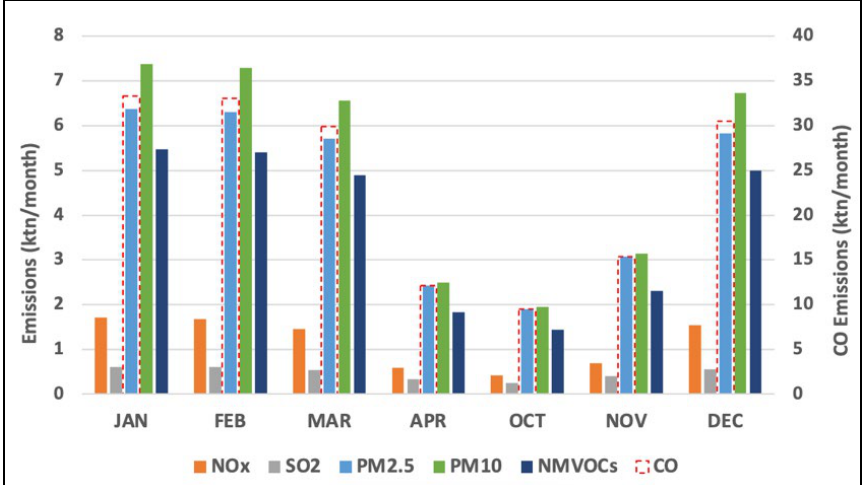
Figure 4. Monthly variation in total “on-line” heating emissions (in ktn/month) for NO x , SO 2 , PM2.5, PM10, ΝΜVOCs and CO (secondary axis) over Greece for the cold period of 2015 (January–April, October–December).